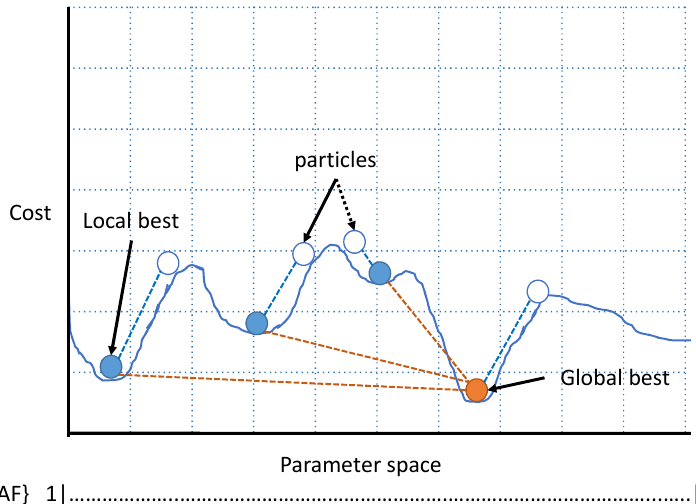
Figure 7. The estimation of parameter by Particle Swarm Optimization algorithm using value space